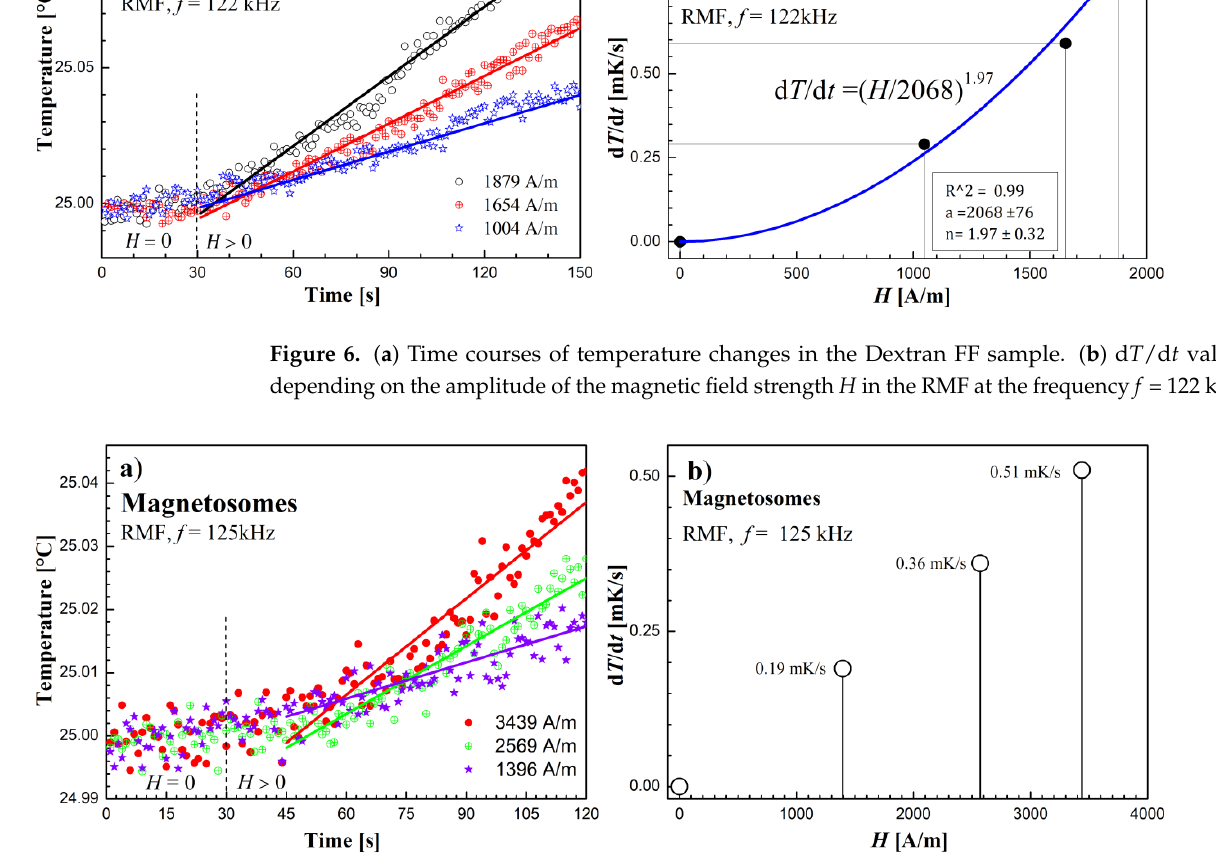
Figure 7. ( a ) Time courses of temperature changes in the magnetosomes sample. ( b ) d T /d t values depending on the amplitude of the magnetic field strength H in the RMF at the frequency f = 125 kHz.